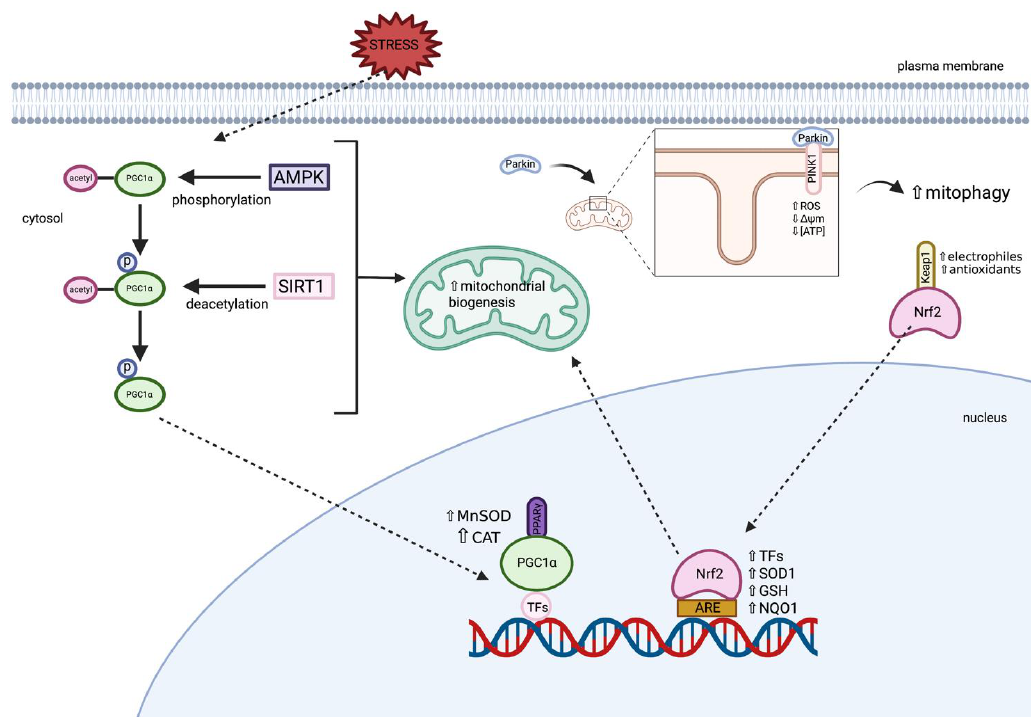
Figure 4. Signaling pathways involved in maintaining a healthy mitochondrial pool in health. PINK1 and parkin have protective roles in neurons and have essential roles in mitophagy. PINK1 accumulates at the outer mitochondrial membrane of damaged mitochondria, initiating the translocation of parkin from the cytosol to mitochondria, activating parkin and selecting damaged mitochondria for removal via mitophagy. The activation of PGC1 α regulates mitochondrial biogenesis, leading to upregulation of several transcription factors and cellular antioxidants. PGC1 α is directly regulated via AMPK phosphorylation and SIRT1-mediated deacetylation which induces mitochondrial biogenesis. PPAR γ is a positive regulator of mitochondrial biogenesis and interaction between PPAR γ and PGC1 α allows PGC1 α to interact with several transcription factors and restore the cellular redox environment by regulating the expression of cellular antioxidants, including MnSOD and CAT. Nrf2 is bound to Keap1 in the cytosol and migrates and accumulates in the nucleus upon activation by antioxidants and electrophiles. Nrf2 binds to the promoter sequence of the ARE where it upregulates the expression of several cellular antioxidants and transcription factors involved in mitochondrial biogenesis [Created using biorender.com]. PINK1 — PTEN-induced kinase 1; ROS — reactive oxygen species; ΔΨm— mitochondrial membrane potential; ATP — adenosine triphosphate; Keap1 — Kelch-like ECH-associated protein 1; Nrf2 — nuclear factor erythroid 2-related factor; PGC1 α— peroxisome proliferator-activated receptor gamma coactivator 1-alpha; AMPK — AMP-dependent